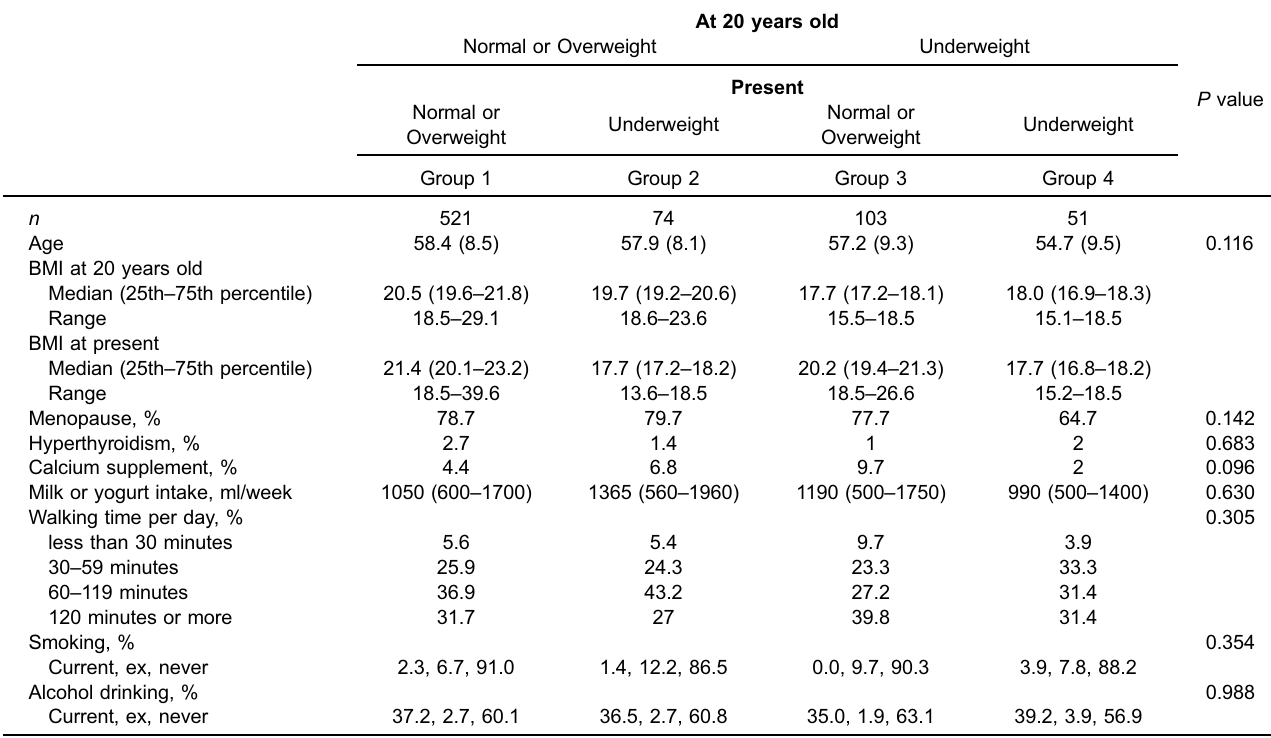
Table 1. Characteristics of participants according to the presence of underweight at 20 years old and/or at present